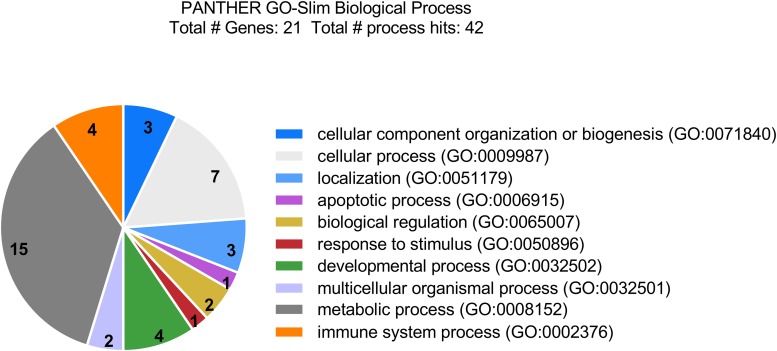
Categorization of differentially accumulated proteins in LCMV-infected HeLa cells by biological functions according to the Gene Ontology database, using PANTHER Classification System. Most of the identified proteins are involved in metabolic processes, cellular processes, such as cellular communication and cell cycle; as well as in immune system processes, and developmental processes.